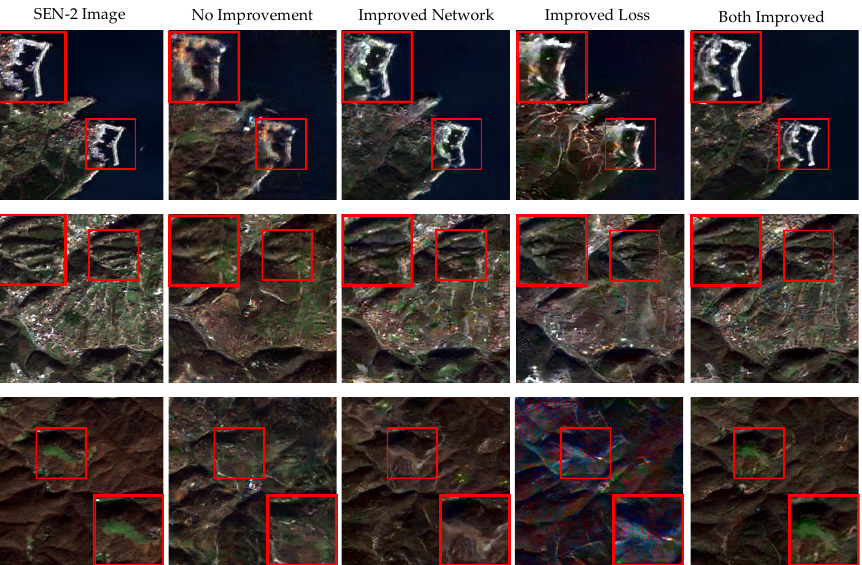
Figure 9. Detailed comparison of Experiment 1. We selected the generated results in three scenarios for detailed comparison with the SEN-2 reference image. The improvement measures proposed in this paper had an obvious effect on improving the quality of the generated images. From left to right: SEN-2 images, images generated by Group 1, images generated by Group 2, images generated by Group 3, and images generated by Group 4.